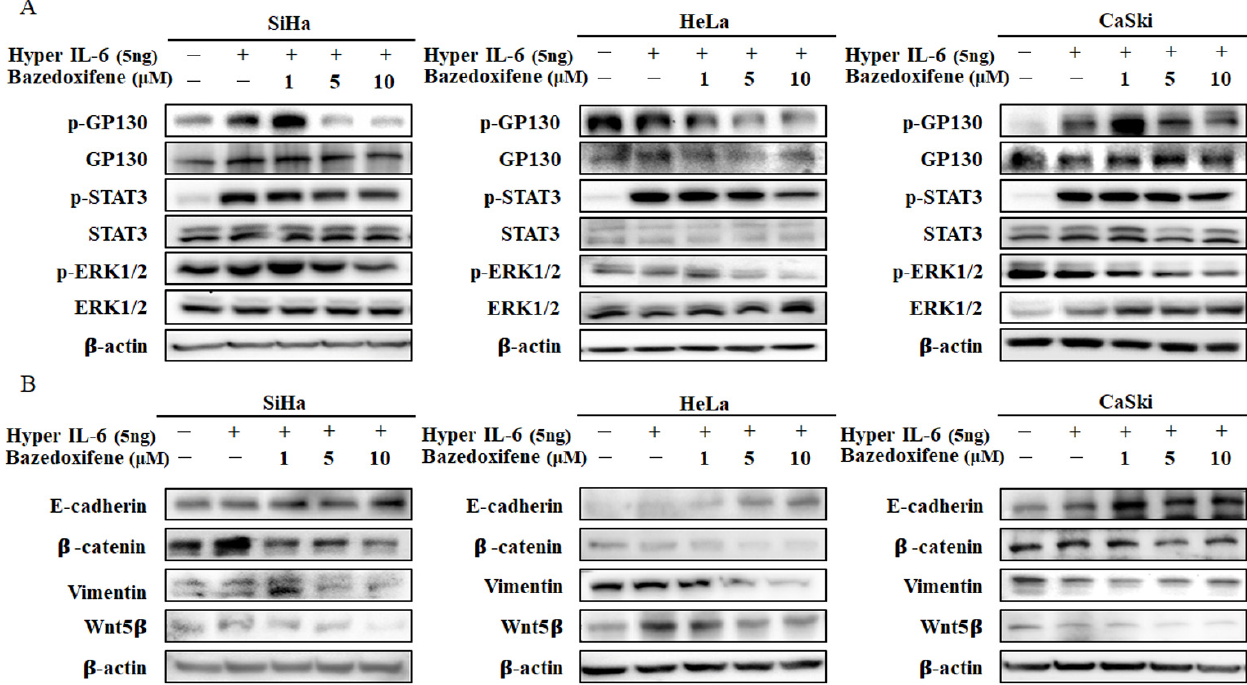
Figure 5. Bazedoxifene inhibited the expression of p-GP130, p-STAT3, p-ERK1/2, and EMT signaling in cervical cancer cells. ( A ) Bazedoxifene decreased the expression levels of p-GP130, p-STAT3, and p-ERK1/2 in SiHa, HeLa, and CaSki cells. ( B ) Bazedoxifene decreased the expression levels of EMT signaling proteins in SiHa, HeLa, and CaSki cells.